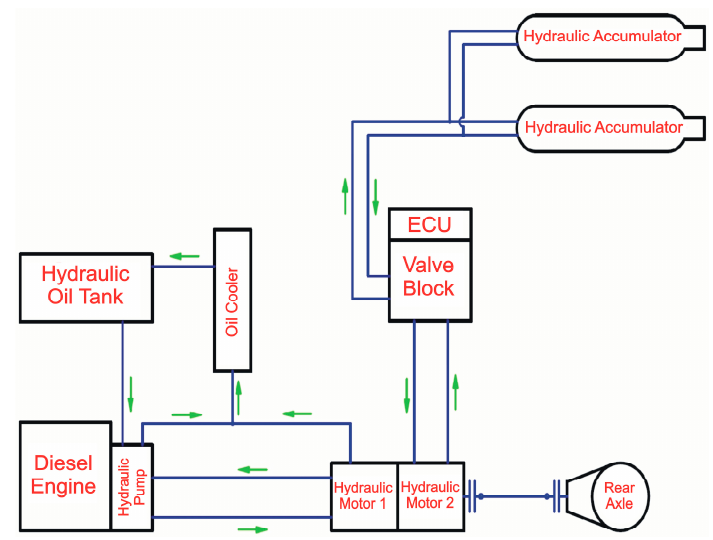
Figure 1. Hydraulic hybrid topology of the DE5 bus.